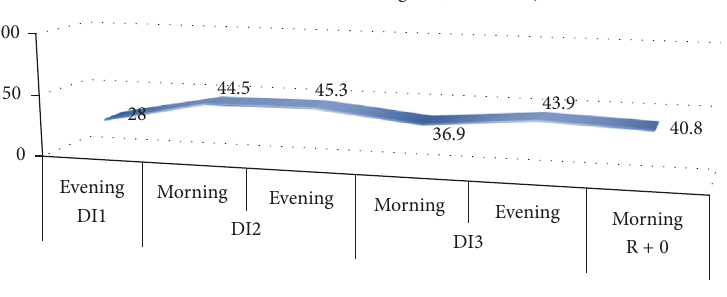
Figure 6: Discomfort during the 3 days in dry immersion (DI1, DI2, and DI3) and at recovery (R + 0). Evaluation by questionnaire using visual analog scale (0–100), with 100 being the most severe level.